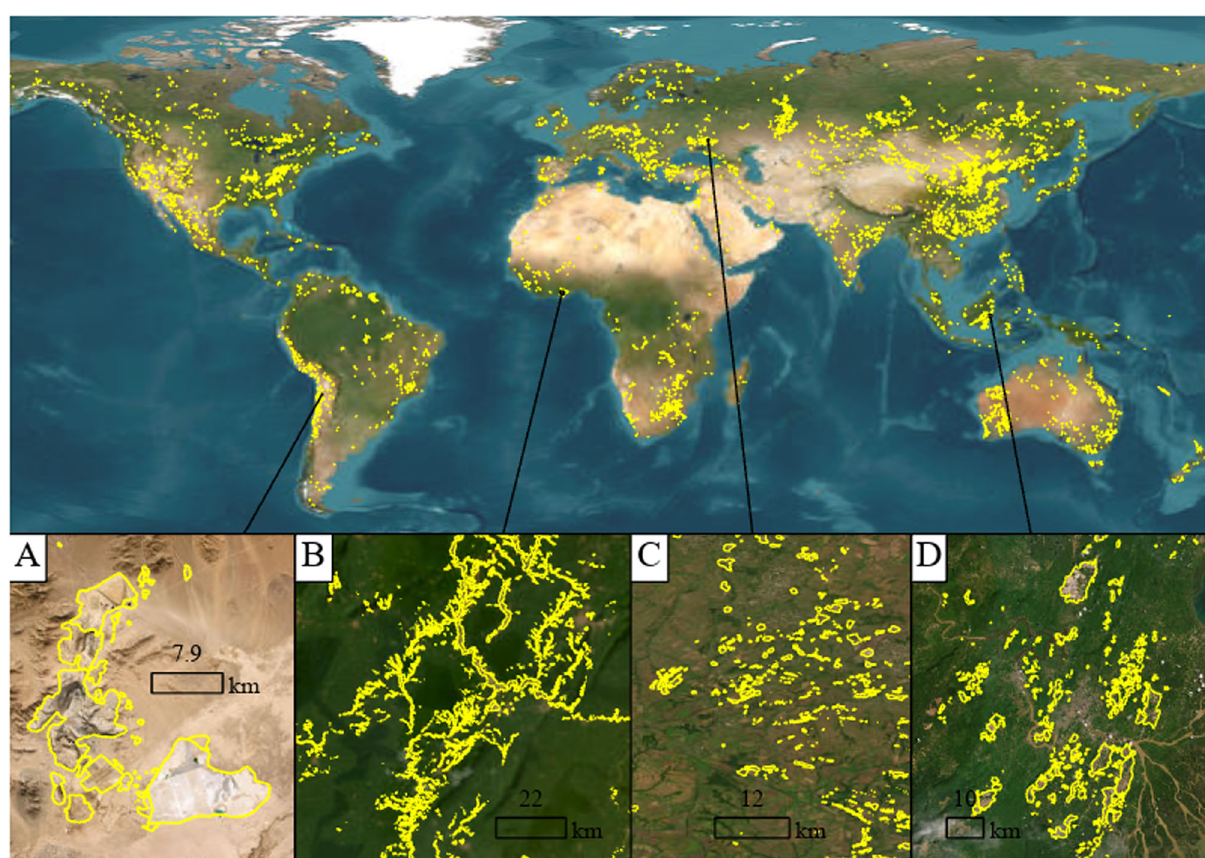
Fig. 1 Global mine area coverage, with cases of delineation of representative mine sites shown. A Larger open pit operations (Escondida mine, copper porphyry deposit, Chile, 24°16 ’ 15 S, 69°4 ’ 14 W); B Formal/artisanal placer gold mining, Ankobra River, Ghana, where all mining sites are along the riversides or in the riverbed, forming a dendritic con fi guration (5°43 ’ N, 2°6 ’ W). C Coal mine sites and gangue heaps in Donetsk, Ukraine (48°12 ’ N, Geographics.